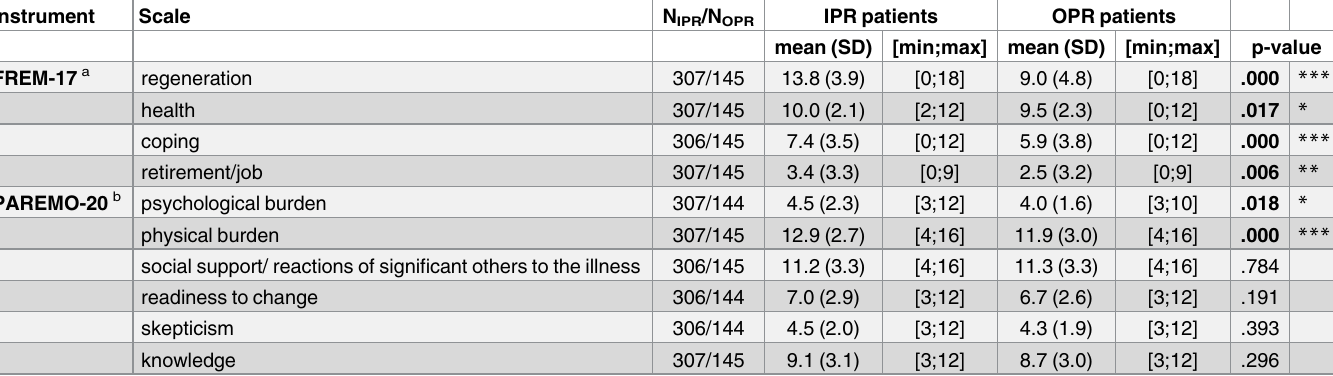
Table 1. Comparison of rehabilitation-related motivations and expectations in patients preferring inpatient or outpatient rehabilitation setting.